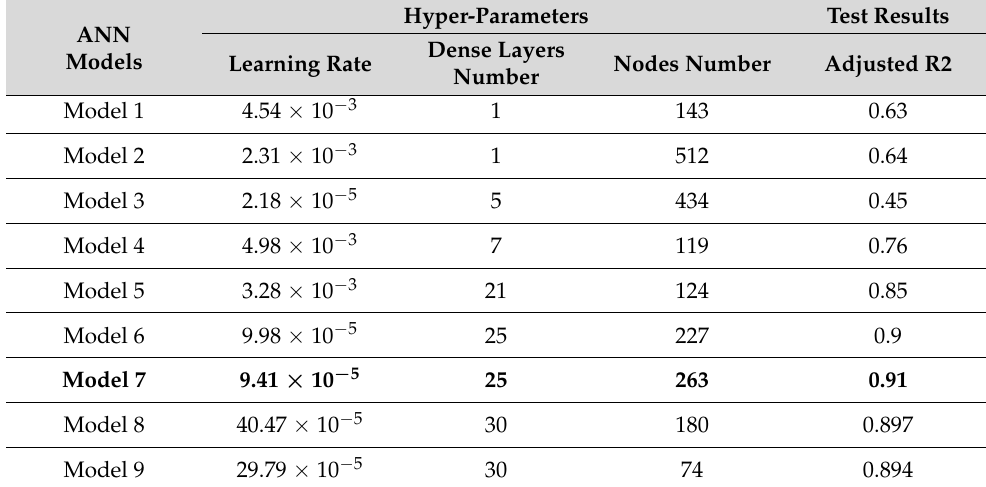
Table 5. Results of different ANN architectures (Model 7 achieves best